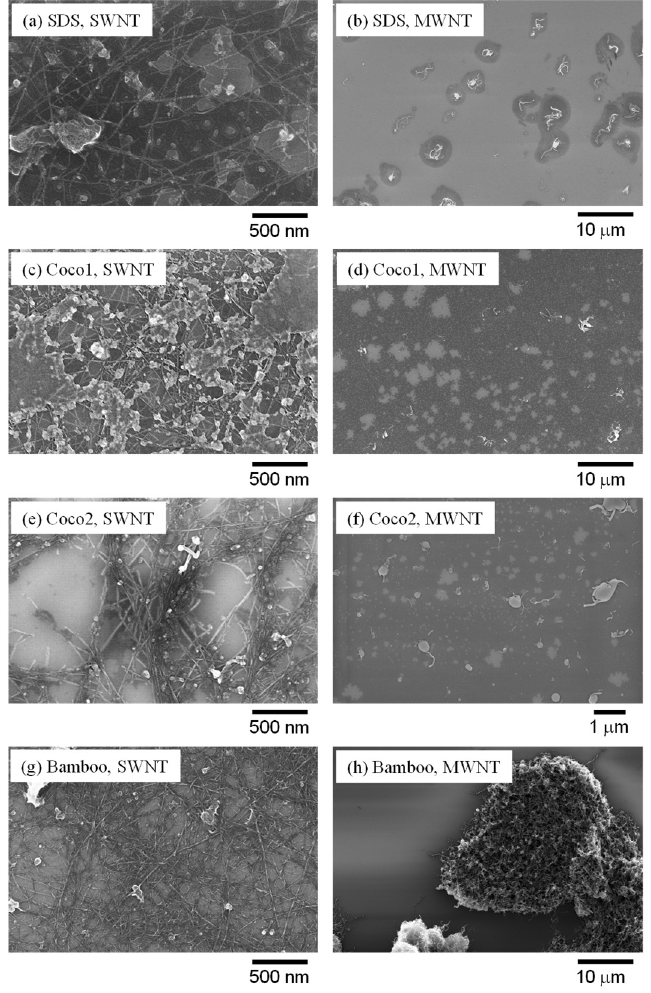
Figure 3. SEM of absorbance of CNT suspensions at 400, 600 and 800 nm. ( a ) SWNTs with SDS, ( b ) MWNTs with SDS, ( c ) SWNTs with Coco1, ( d ) MWNTs with Coco1, ( e ) SWNTs Coco2, ( f ) MWNTs with Coco2, ( g ) SWNTs with Bamboo, ( h ) MWNTs with Bamboo.